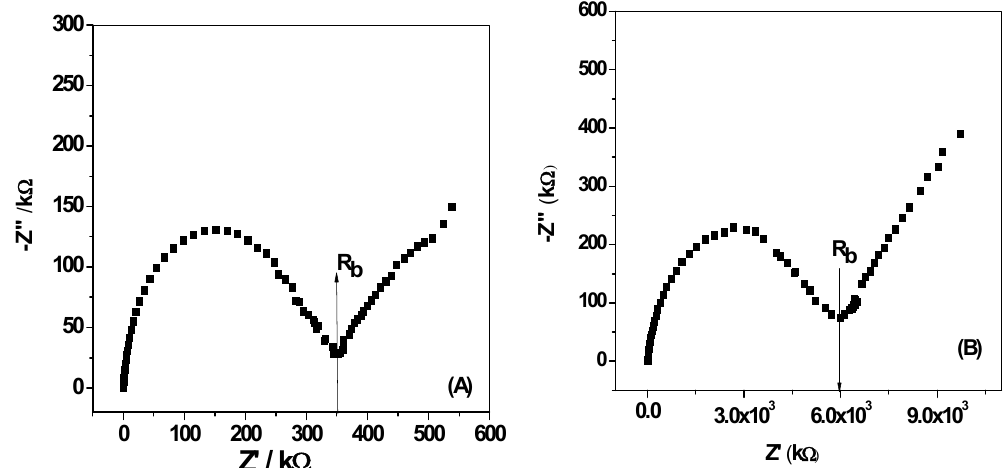
Figure 9. Impedance plot ( A )for DCP/MIP -ISEs with and, ( B ) without PANI as a solid contact material.